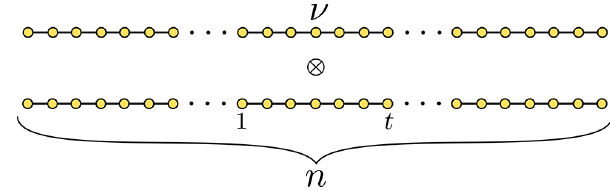
FIG. 6. Pictorial representation of the arrangement of the dual quantum spin degrees of freedom adopted in the tensor product space H ⊗ 2 n t